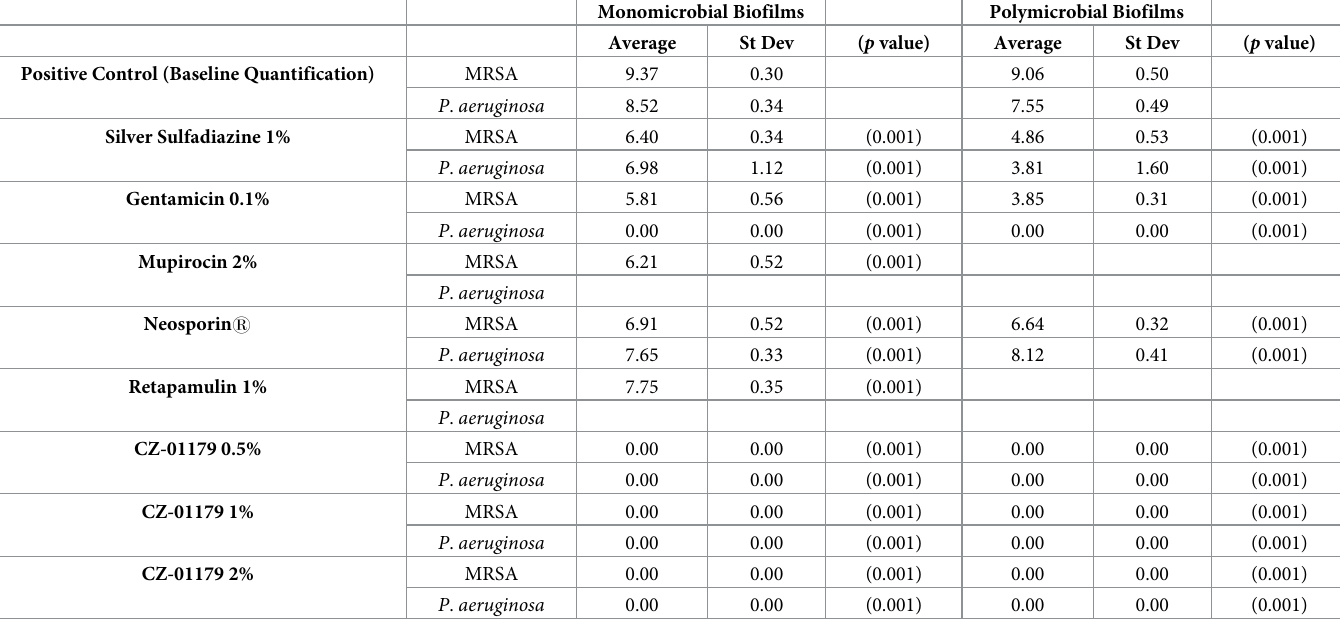
Table 1. Remaining log 10 transform CFU/collagen coupon following 24 h of topical treatment. Each collagen coupon received 2g of topical agent applied in the speci- fied concentrations.